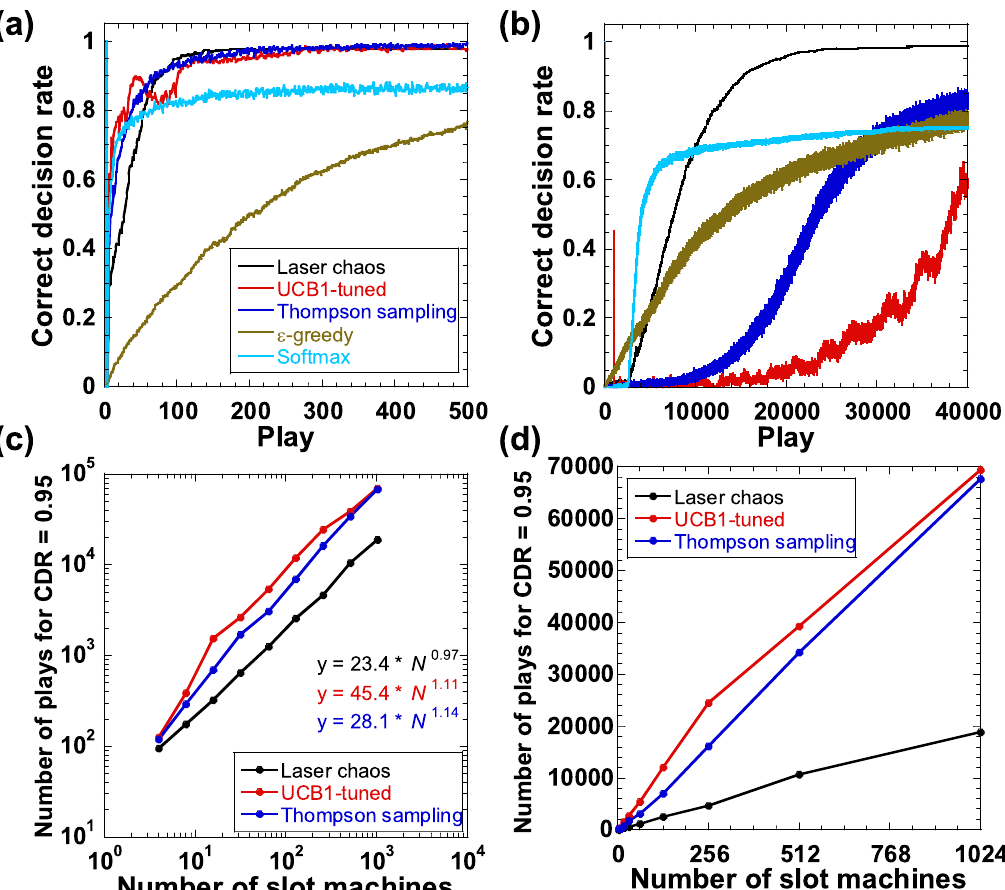
Figure 4. Comparison of correct decision rate (CDR) and scaling characteristics for the laser-chaos-based method (black), the UCB1-tuned (red), Thompson sampling (blue), ε -greedy (brown), and softmax (light blue) algorithms. ( a ) CDR as the number of plays increases for N = 4; ( b ) CDR as the number of plays increases for N = 1024; and ( c ), ( d ) scaling characteristics for the relationship between the number of plays y at which the CDR reaches 0.95 and the number of slot machines N for laser-chaos-based method (black), UCB1-tuned (red), and Thompson sampling (blue) algorithms on ( c ) double logarithmic and ( d ) double linear scales. The hyperparameter values are optimized for the ε -greedy and softmax algorithms for different N